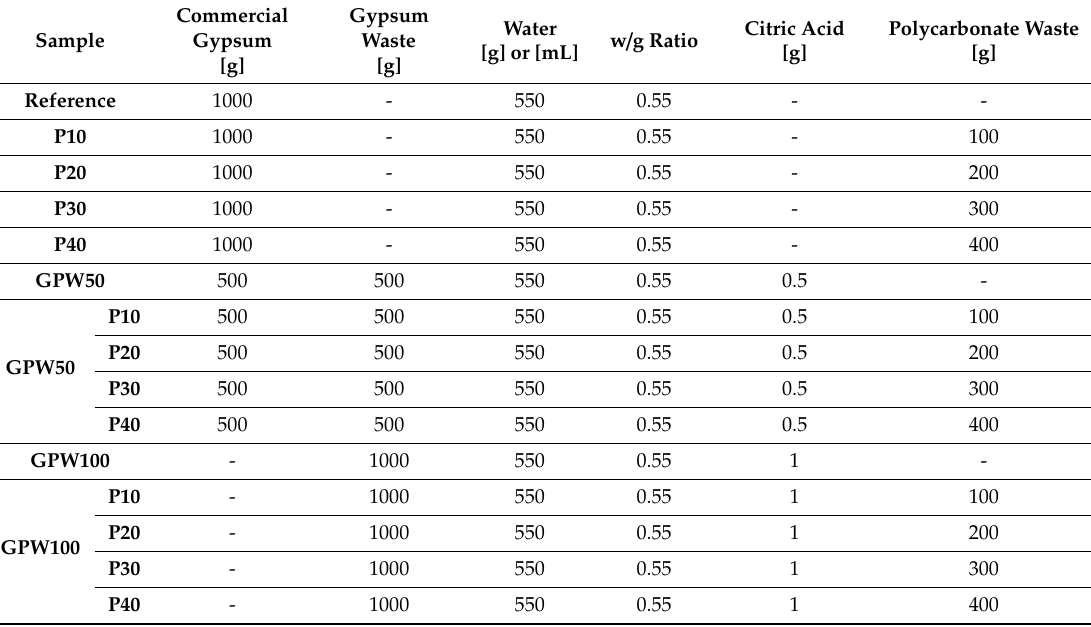
Table 1. Composition of all the gypsum mixes under